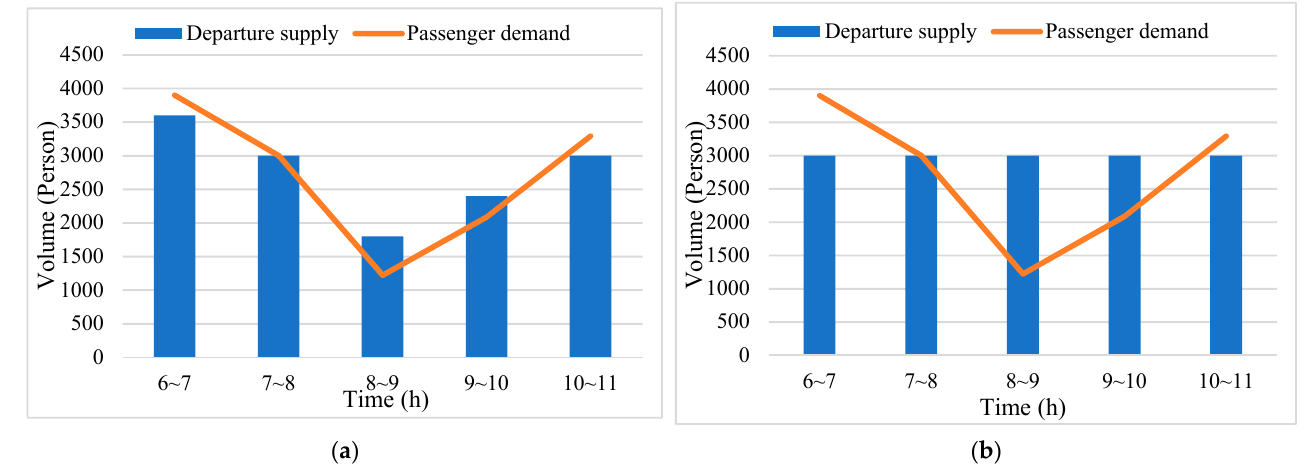
Figure 4. Multi-cycle train timetable and single-cycle train timetable under scenario 1. ( a ) Multi- cycle train timetable. ( b ) Single-cycle train timetable. Red, green, blue, orange, violet, navy blue and purple represents Line 1, 2, 3, 4, 5, 7 and 10 in Table 3, respectively.